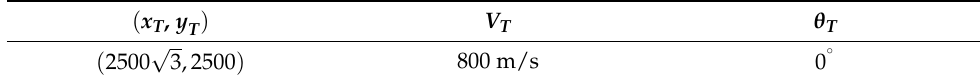
Table 2. Initial simulation values of the target. ( x T , y ) V T θ T T √ ( 2500 3,2500 ) 800 m/s 0 ◦